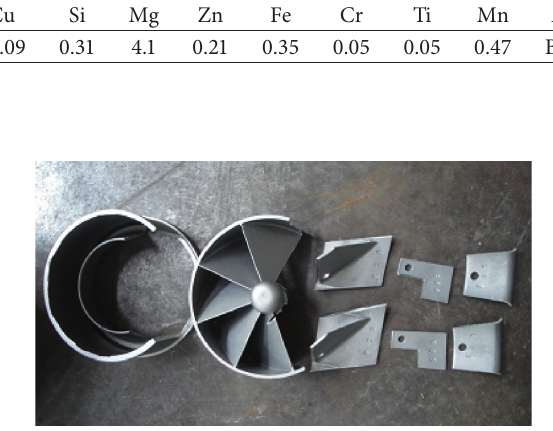
Figure 1: Test trial sample of cyclone